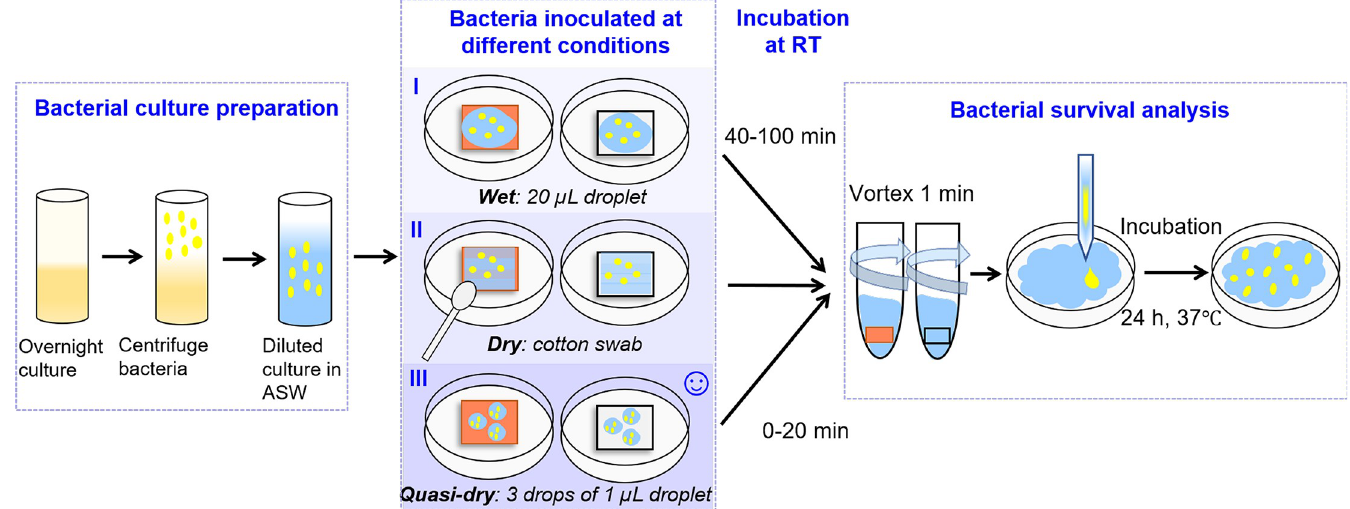
Fig 2. Schematic illustration of the three methodological approaches performed to assess the antimicrobial properties of high touch surfaces of relevance for indoor atmospheric conditions (Cu metal used as a benchmark surface).